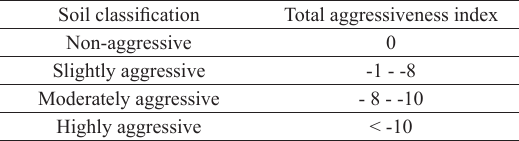
Table 8. Soil aggressiveness partial